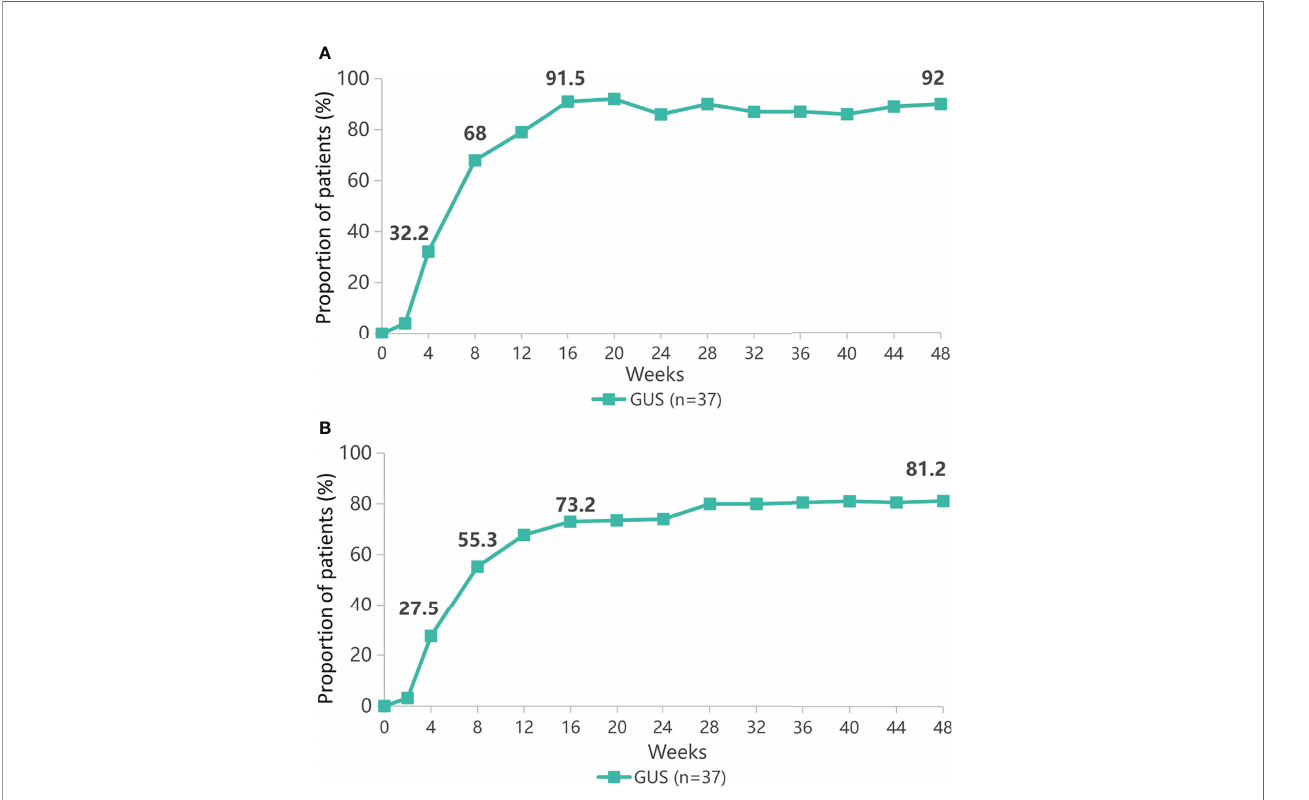
FIGURE 1 | The proportion of patients with psoriasis area and severity index (PASI 75) remission (A) or PASI 90 remission (B) from baseline to 48